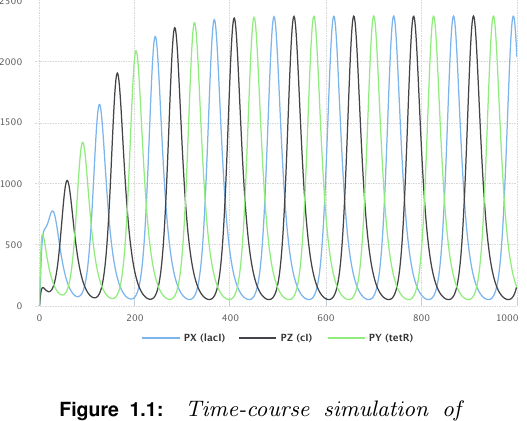
Figure 1.1: Time-course simulation of the repressilator depicting repressor pro- teins lacI, tetR and cI. Simulation with SED-ML web tools [2].